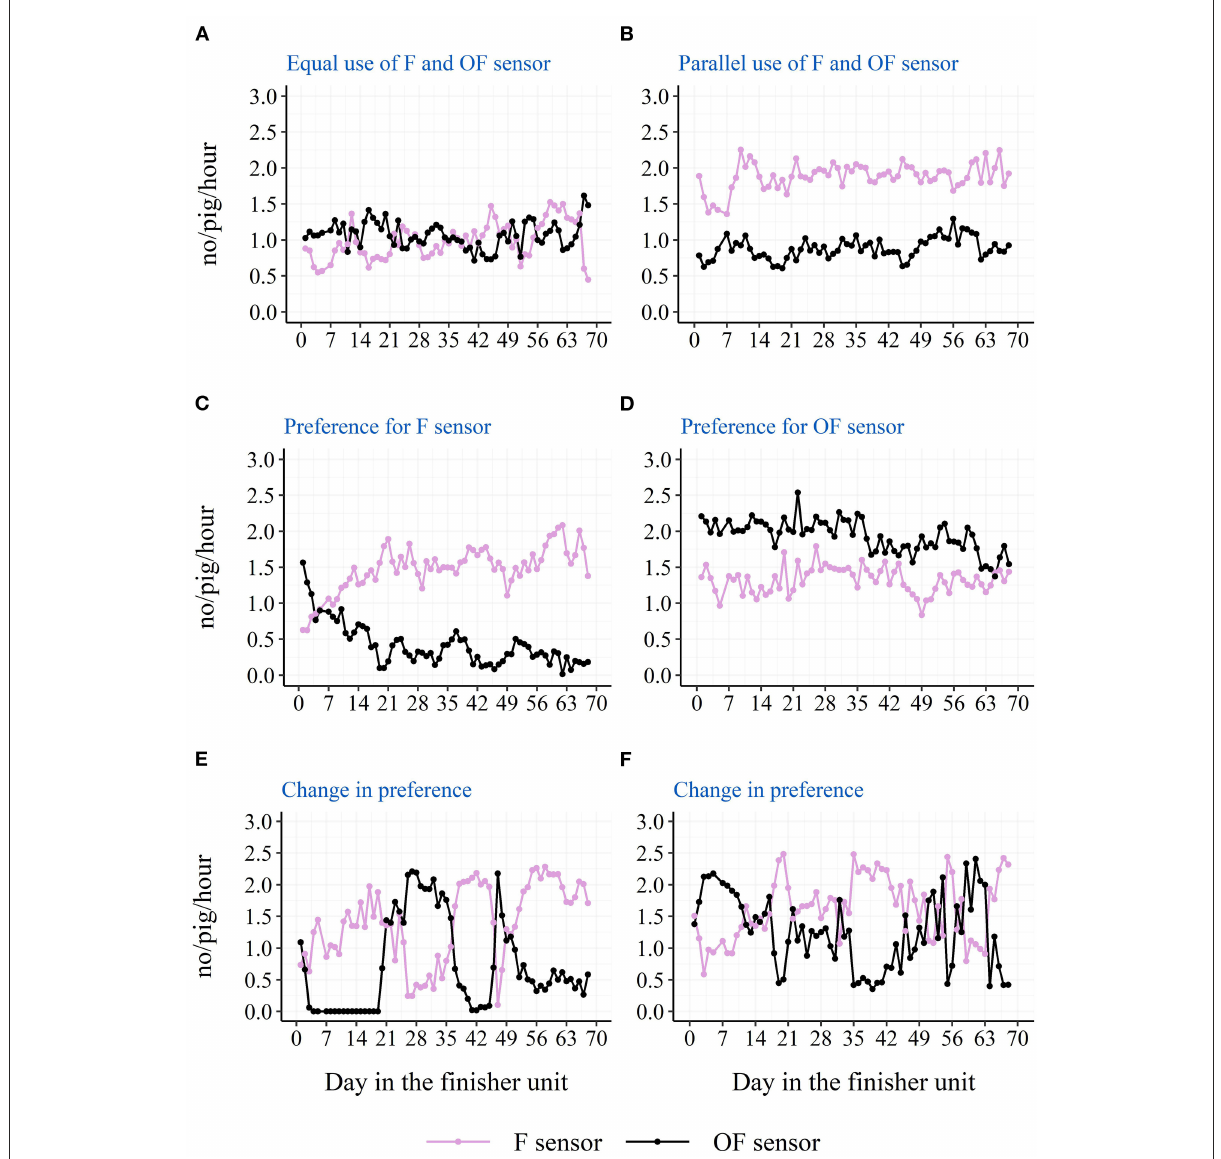
FIGURE8 Examples from batch 4 of single pens variations in raw average hourly activations of the two drinking cups (F sensor: at the same side of the pen as the feeder; OF sensor: on the opposite side of the pen as the feeder). (A) Docked tails, without straw, high stocking density. (B) Docked tails, with straw, low stocking density. (C,D) Docked tails, without straw, low stocking density. (E,F) Docked tails, with straw, high stocking